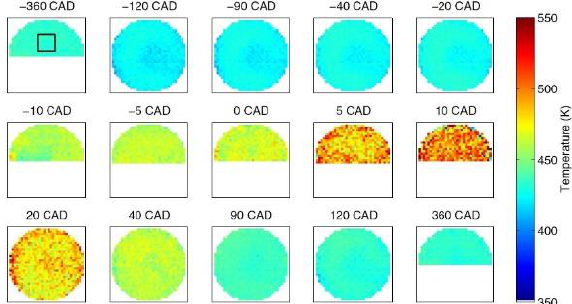
Figure 27. Phase-locked temperature distribution of the cylinder wall under fired conditions [88]. Reprinted with permission from [88]. IOP Publishing, Ltd.,